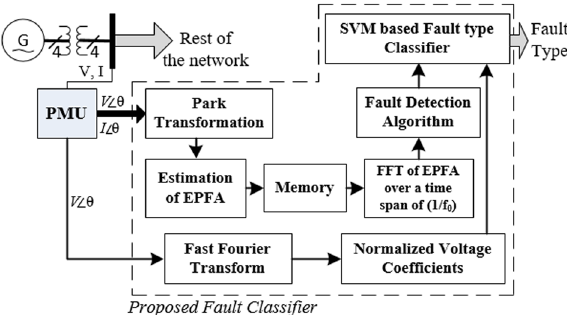
Fig. 9 Schematic diagram of fault classifier module in the proposed backup fault monitoring